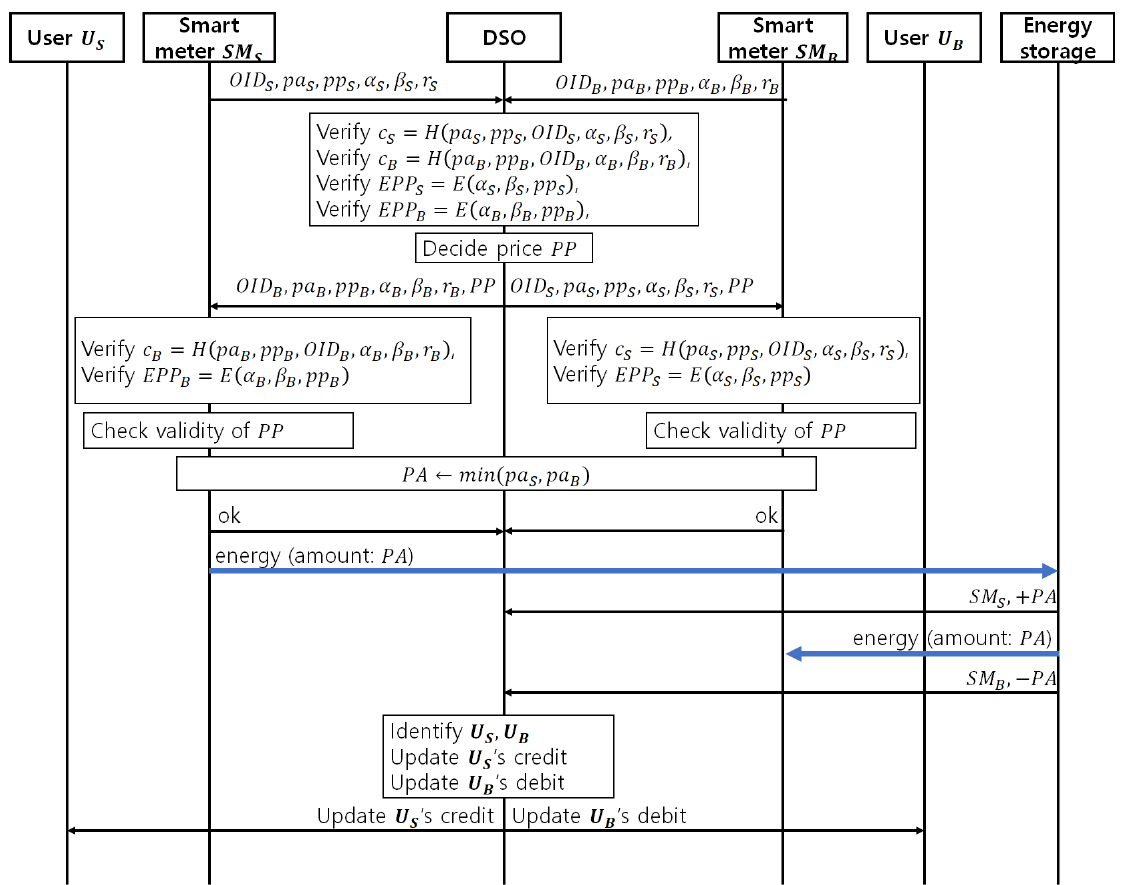
Figure 4. Trading stage of the proposed